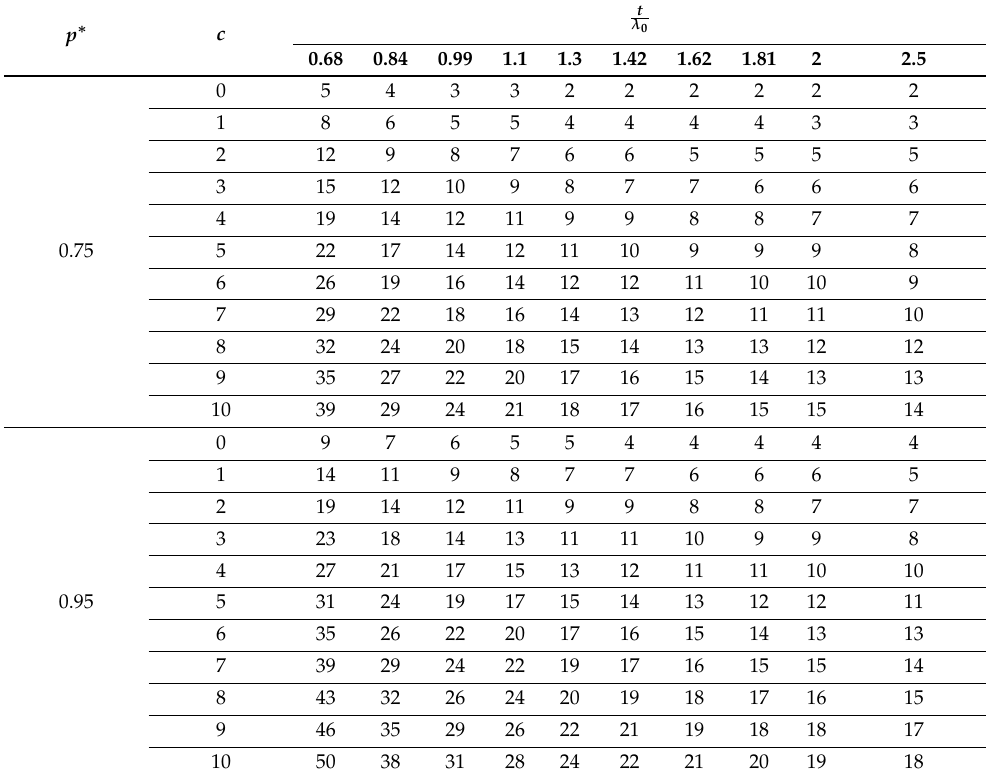
, λ = 1.3, θ = 2, and δ = 2.5 for the Poisson λ 0